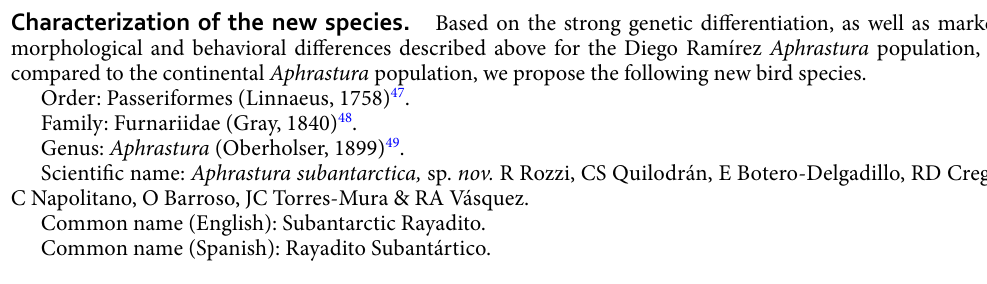
were assigned to a population different from the one from which they were captured. This was true for some birds in the central and southern clusters, but not for any individual from Diego Ramírez (100% correct assignment; Fig. 6). These results are in line with the analysis using GeneClass2, in which no first-generation migrants were detected in Diego Ramírez for any of the 10 replicates performed, whereas the southern cluster harbored four potential immigrants from the central cluster (Supplementary Information Appendix 4).